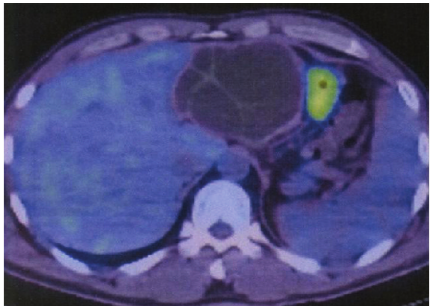
Figure 3: Positron emission tomography revealed no abnormal fluorodeoxyglucose uptake in the hepatic cyst or the cystic wall.